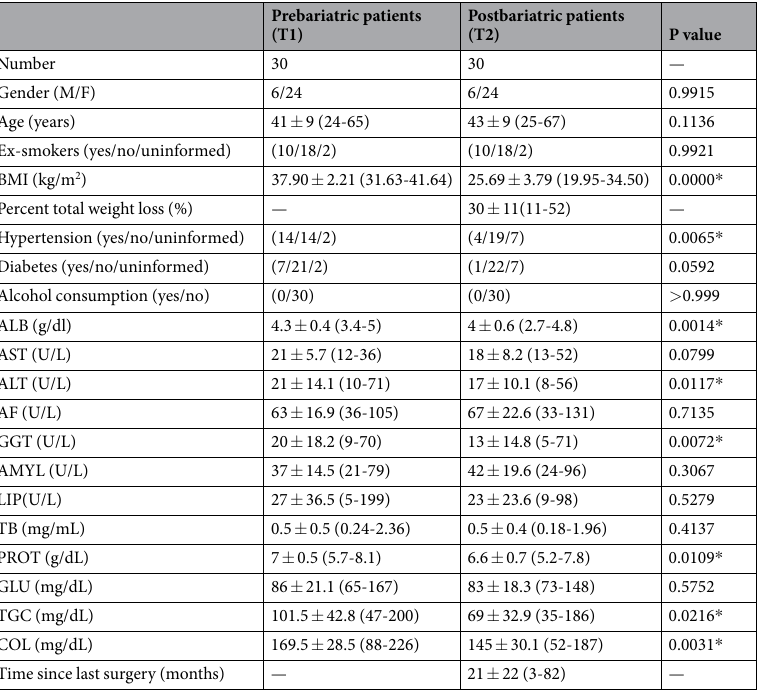
Table 2. Clinical and demographic characteristics of patients at the time and after bariatric surgery and the control group. Numerical variables are described as median [min. max] and categorical variables as absolute frequencies. M = male. F = female. BMI = body mass index. ALB = plasma albumin. AST = aspartate aminotransferase. ALT = alanine aminotransferase. AF = alkaline phosphatase. GGT = gamma glutamyl transferase. AMYL = amylase. LIP = lipase. TB = total bilirubin. PROT = total protein. GLU = glucose. TGC = triglyceride. COL = total cholesterol. * p < 0.05 T1 vs. T2. For “ex-smokers”, “hypertension” and